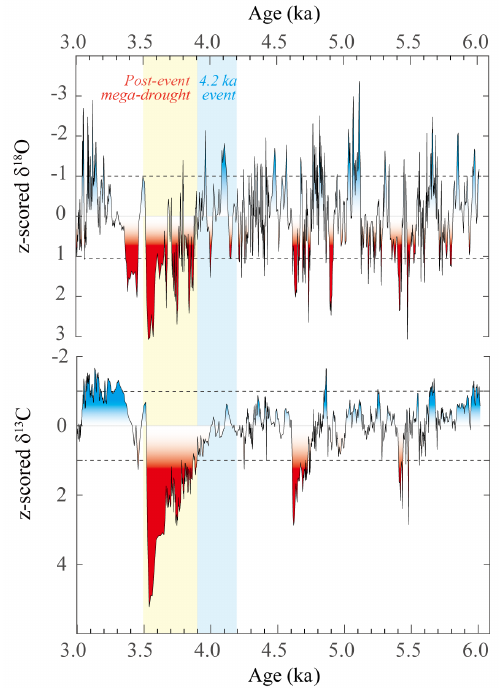
Figure 3. Inferred hydro-climatic variability at Rodrigues from 6 to 3ka. LAVI-4 δ 18 O and δ 13 C record are z-score transformed. In- ferred droughts (z-score > 1) and pluvial episodes (z-score < − 1) are shaded (increasing saturation index indicates increasing inten- sity). Dashed lines indicate 1 standard deviation. The blue bar marks the classical 4.2ka event interval and the yellow bar marks the “post-event” mega-drought, inferred from